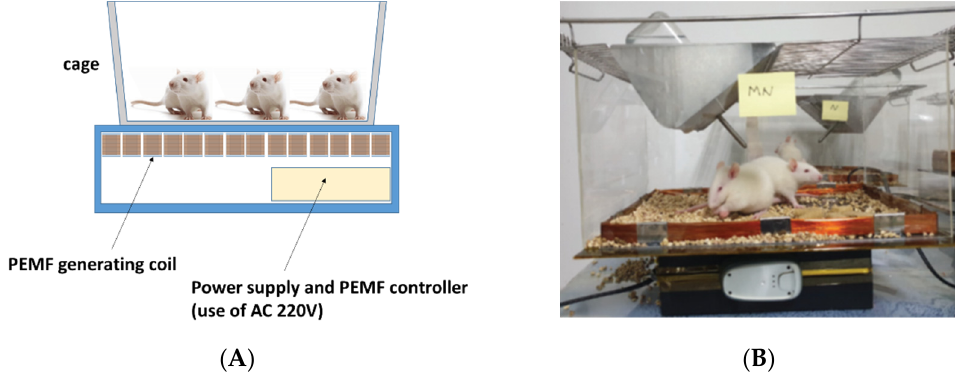
Figure 2. Installation of experimental cage. ( A ) Diagram of the experimental cage and pulsed electromagnetic field device and ( B ) installation of the experimental cage.